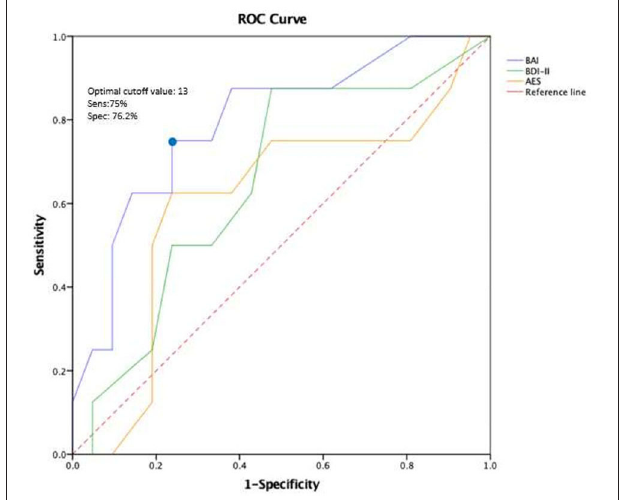
FIGURE 2 | ROC curve of BAI, AES, and BDI-11 at baseline to predict MCI after three years of follow-up. Discriminant analysis based on the receiver operating characteristics (ROC) curve represents the predictive power of BAI, BDI-ll, and AES for the development of MCI. BAI, Beck Anxiety Inventory; BDI-11, Beck Depression Inventory-II; AES, Apathy Evaluation